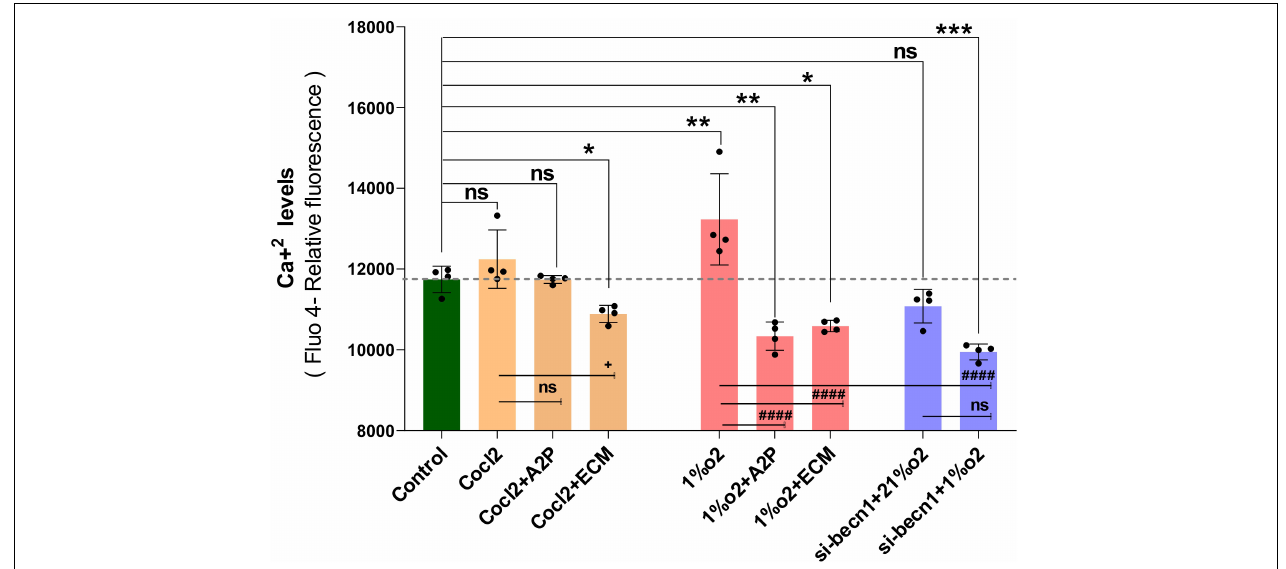
FIGURE 1 | H9c2 cells grown under Hypoxia expressed decreased intracellular Calcium ([Ca 2 + ] i ) levels. The graph indicates the (Fluo-4 NW calcium assay) relative fluorescence changes of intracellular calcium levels in H9c2 cells treated with different molecules (ECM, A2P, siRNA-Beclin1) grown under CoCl2, Hypoxia (1%O2) and Normoxia conditions (21%O2). Hypoxia increased the cellular Ca2 + levels (** p < 0.003) compared to controls and was decreased in the cells treated with antioxidant-A2P (** p < 0.006) and in HIF-1 inhibitor- ECM group (* p < 0.028). Beclin-1 inhibition reduced the Ca2 + levels in hypoxic (1% O 2 ) cells, *** p < 0.0005, but not in normoxia. Ca 2 + levels also decreased in Cocl2 + ECM group (* p < 0.028) and not changed significantly in Control vs. Cocl2, Cocl2 + A2P group. Compared to Hypoxia cells (Cells grown under only hypoxia-1%O 2 /without Echniomycin (HIF inhibitor), A2P (anti-oxidant), and small interfering RNA to beclin-1-inhibition), cells grown with Hypoxia (1%O2) + A2P ( #### p < 0.0001), (1%O2) + ECM ( #### p < 0.0001), and in Beclin-1 inhibition ( #### p < 0.0001), cells grown under Hypoxia expressed significant decrease in Ca2 + levels. Data represents, n = 4 independent samples/group; Bars are mean ± S.D. Symbols * , + , # , and (cid:54)= denotes significant, “ns” represents not significant by two-way ANOVA- multiple comparisons test. P-values are ns p > 0.05, * p < 0.05, ** p < 0.01, *** p < 0.001, and **** p < 0.0001 compared to Control; + p < 0.05, ++ p < 0.01, +++ p < 0.001, and ++++ p < 0.0001 compared to Cocl2; # p < 0.05, ## p < 0.01, ### p < 0.001, and #### p < 0.0001 compared to Hypoxia; (cid:54)= p < 0.05, (cid:54)= (cid:54)= p < 0.01, (cid:54)= (cid:54)= (cid:54)= p < 0.001, and (cid:54)= (cid:54)= (cid:54)= (cid:54)= p < 0.0001 compared to si-becn1 (21%O2) Vs, si-becn1